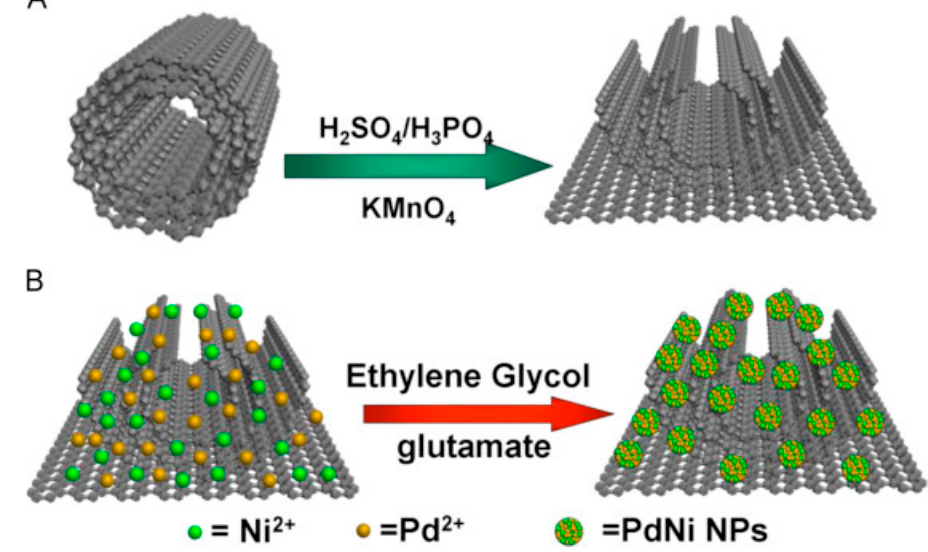
Figure 14. ( A ) The synthetic process of N-GNRs from N-MWCNTs; ( B ) The synthetic process of PdNi/N-GNRs. Reproduced with permission from [39].